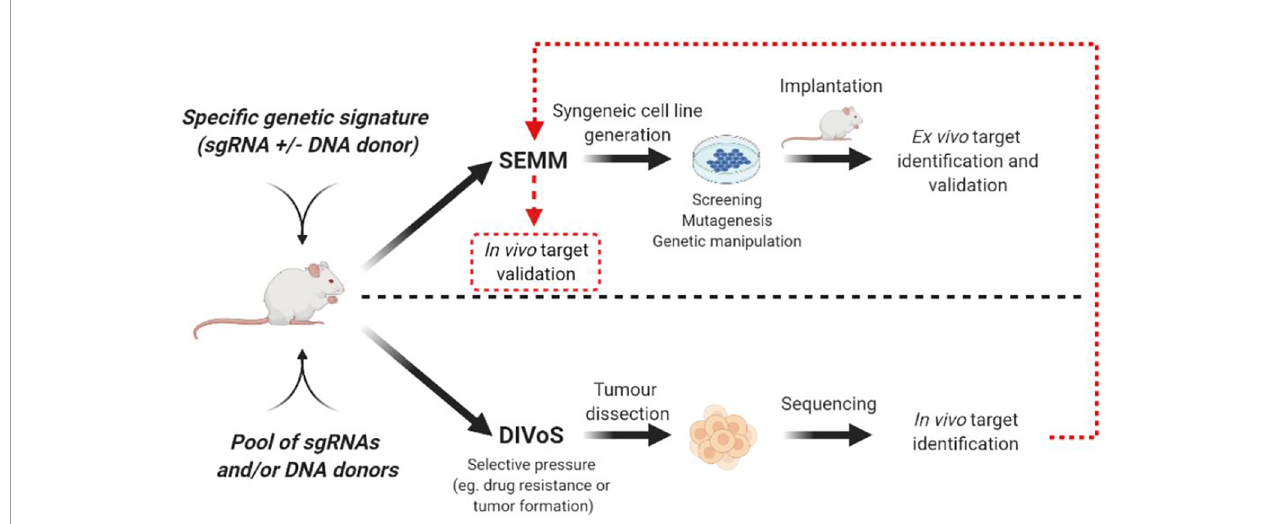
FIGURE 2 | Representative work fl ow for SEMM generation and DIVoS design starting from CRISPR/Cas9 in vivo delivery. Targets identi fi ed with DIVoS are eventually validated with the generation of a SEMM (red dotted